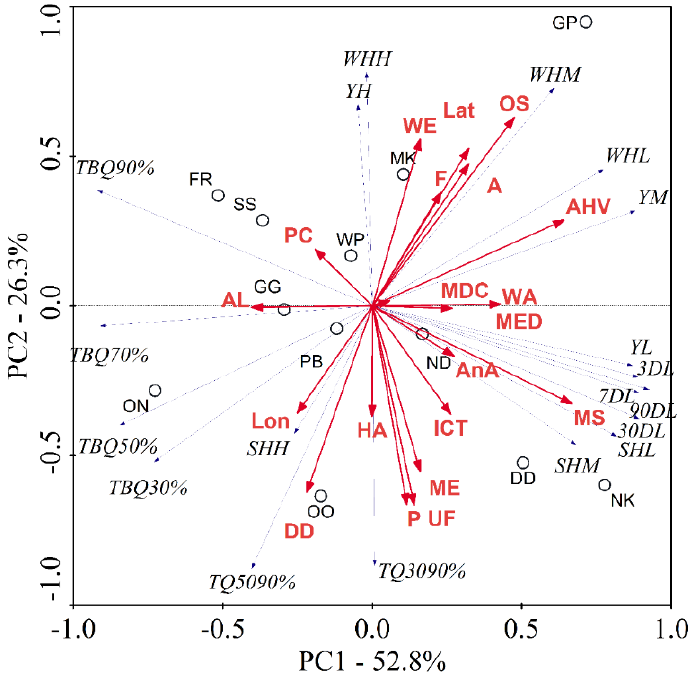
Figure 5. Results of principal component analysis. Catchment area (A); drainage density (DD); mean slope (MS); mean elevation (ME); maximum elevation difference (MED); longitude (Lon); latitude (Lat); land use characteristics—urban fabric (UF), industrial, commercial and transport units (ICT); mine, dump and construction sites (MDC); artificial, non-agricultural vegetated areas (AnA); arable land (AL); permanent crops (PC); pastures (P); heterogeneous agricultural areas (HA), forests (F); scrub and/or herbaceous vegetation associations areas (AHV); open spaces with little or no vegetation (OS); wetlands (WE) and waters (WA).